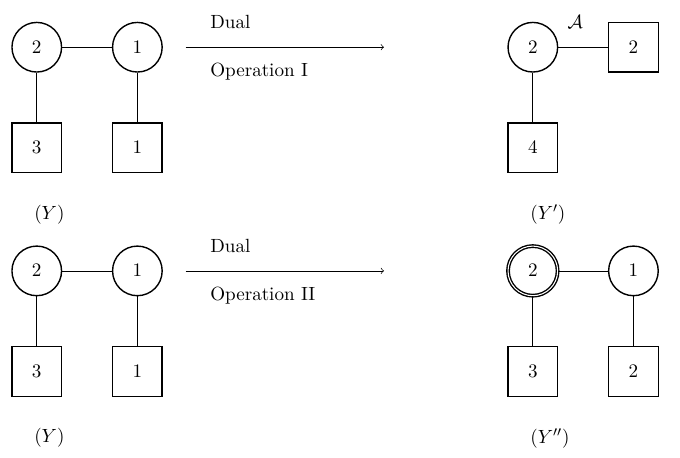
Figure 44 . This figure shows dual operations for different choices of the permutation matrix P . The quiver ( X 0 ) in figure 43 is mirror dual to the quivers ( Y 0 ) and ( Y 00 ) . The quiver ( Y 0 ) has a pair of hypermultiplets in the rank-2 antisymmetric representation of the gauge group U(2) . Note that the theories ( Y 0 ) and ( Y 00 ) have the same Coulomb and Higgs branch